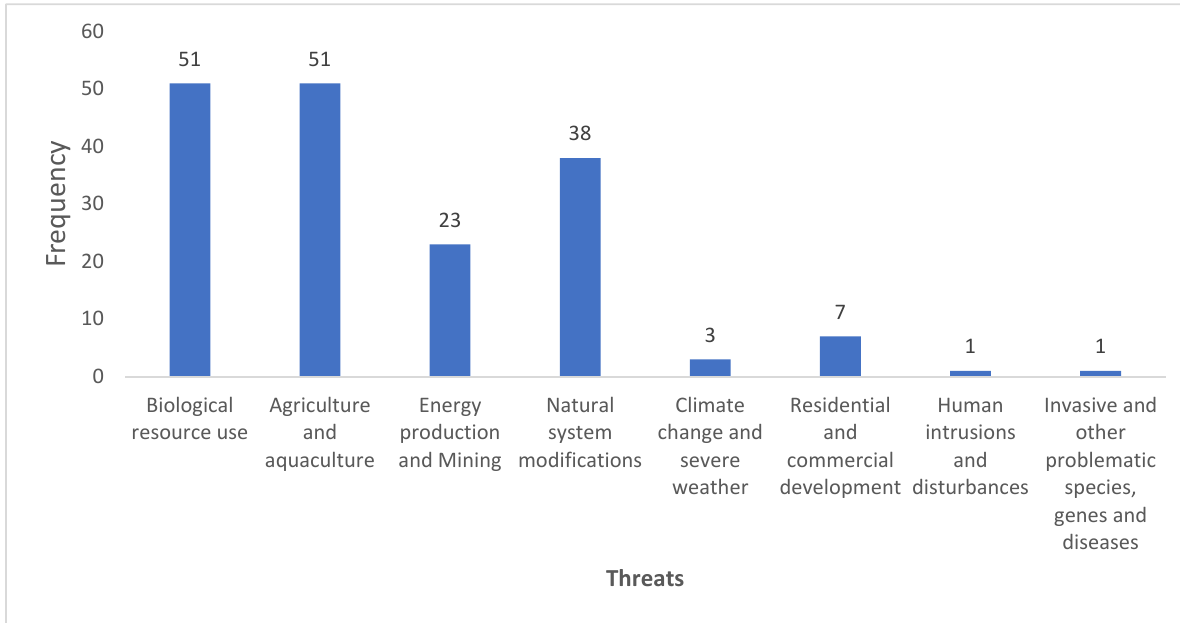
Figure 5. The conservation status of the taxa collected from Tampolo forest basing on the IUCN database: LC- Least Concern; VU- Vulnerable; NT- Near Threatened; CR- Critically Endangered; EN- Endangered.